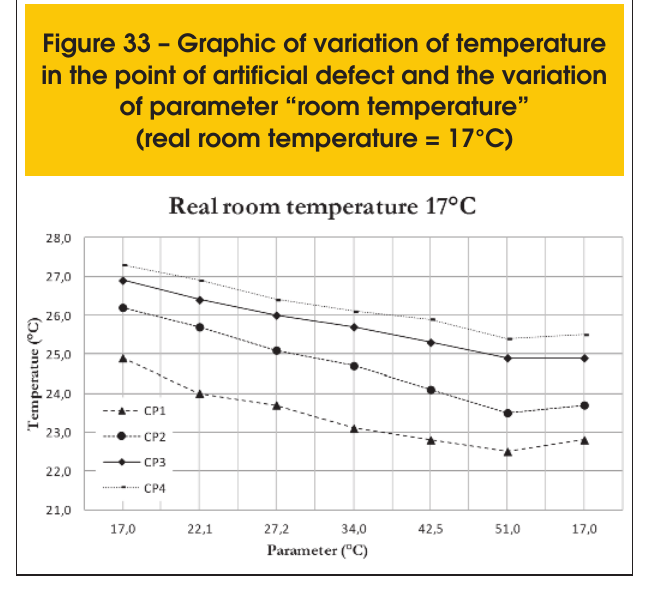
Figure 33 – Graphic of variation of temperature in the point of artificial defect and the variation of parameter “room temperature” (real room temperature = 17°C)